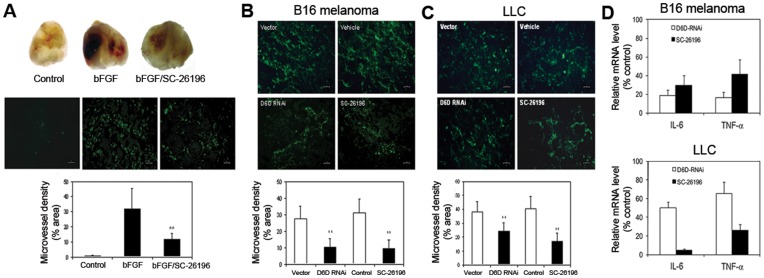
Decreased D6D suppresses tumor angiogenesis and inflammation.(a) SC-26196, a D6D selective inhibitor, at 100 µM significantly inhibited basic fibroblast growth factor (bFGF)-induced angiogenesis in a Matrigel plug assay (**P<0.01; n = 3). (b, c) Immunohistological staining of microvessel density in tumors. Knocking down D6D (with RNAi) or inhibiting D6D (with selective inhibitor SC-26196) reduced angiogenesis in (b) B16 melanoma and (c) LLC tumors (**P<0.01; n = 3). (d) The mRNA expression of the inflammatory factors interleukin-6 (IL-6) and TNF-α is down-regulated in B16 melanoma and LLC lung tumors treated with D6D-RNAi or SC-26196, shown here by percent of control. **P<0.01; n = 4.